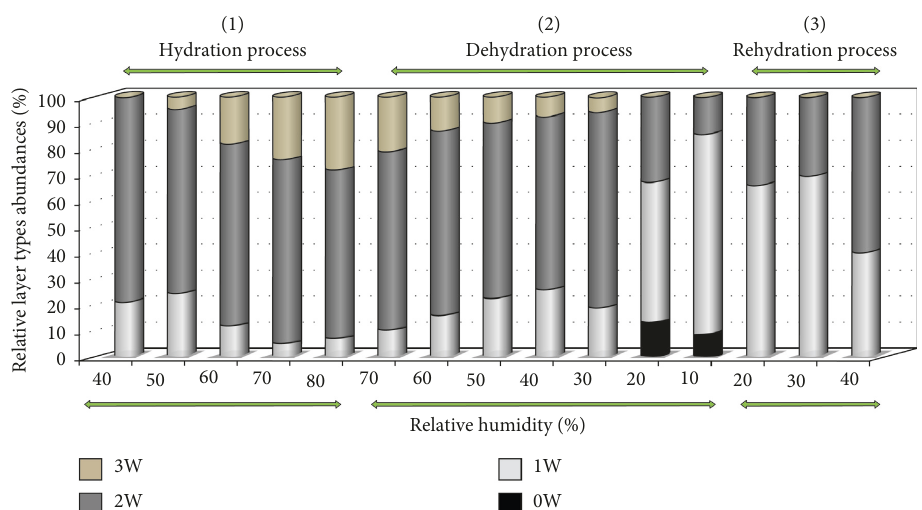
Figure 4: Relative contribution progress of the different layer types (summing up all mixed-layer structures) as function of the RH % along the first